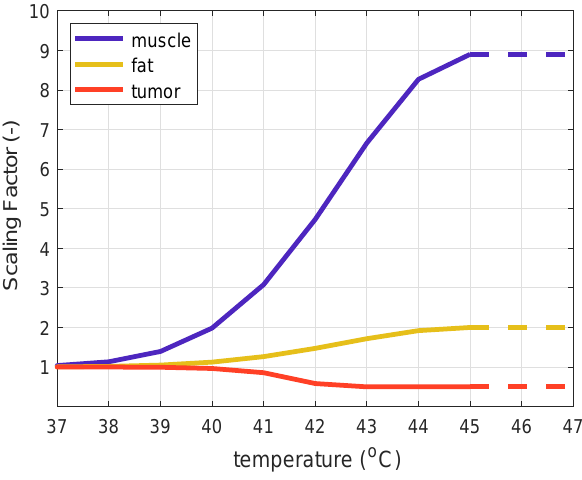
Figure 3. Temperature-dependent scaling factor (SF) for muscle, fat and tumor. Table 2. Patient details including age at the beginning of the HT treatment, gender, CTV location, median, minimum and maximum CTV depths, and amount of received HT